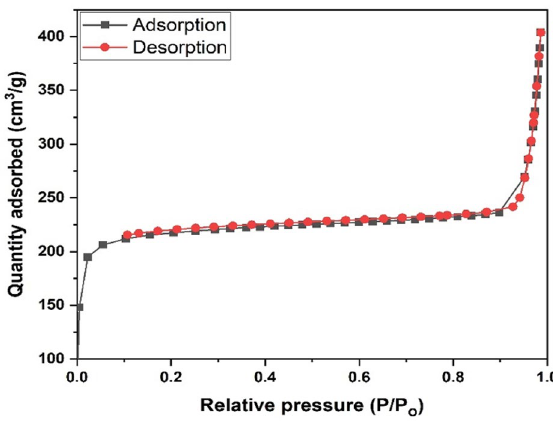
Figure 2. N 2 adsorption/desorption isotherms for PET based